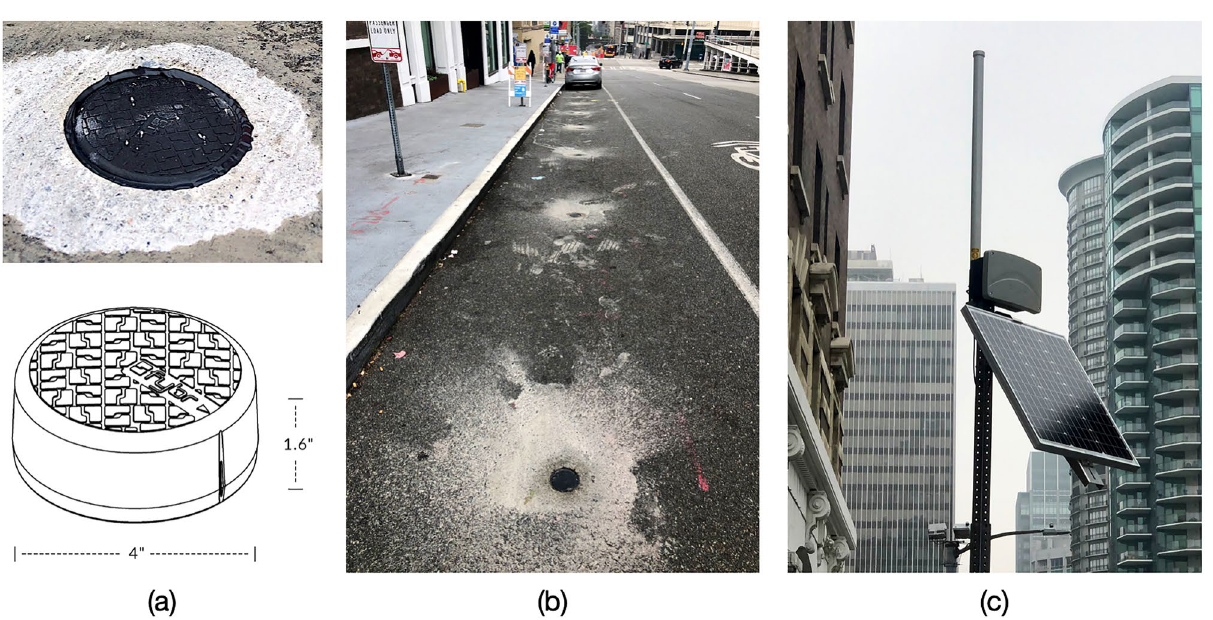
Figure 3. ( a ) Proximity sensors installed in the curb. ( b ) Curb sensors deployment in curb parking spaces. (c) Gateway transmitting and receiving sensors’